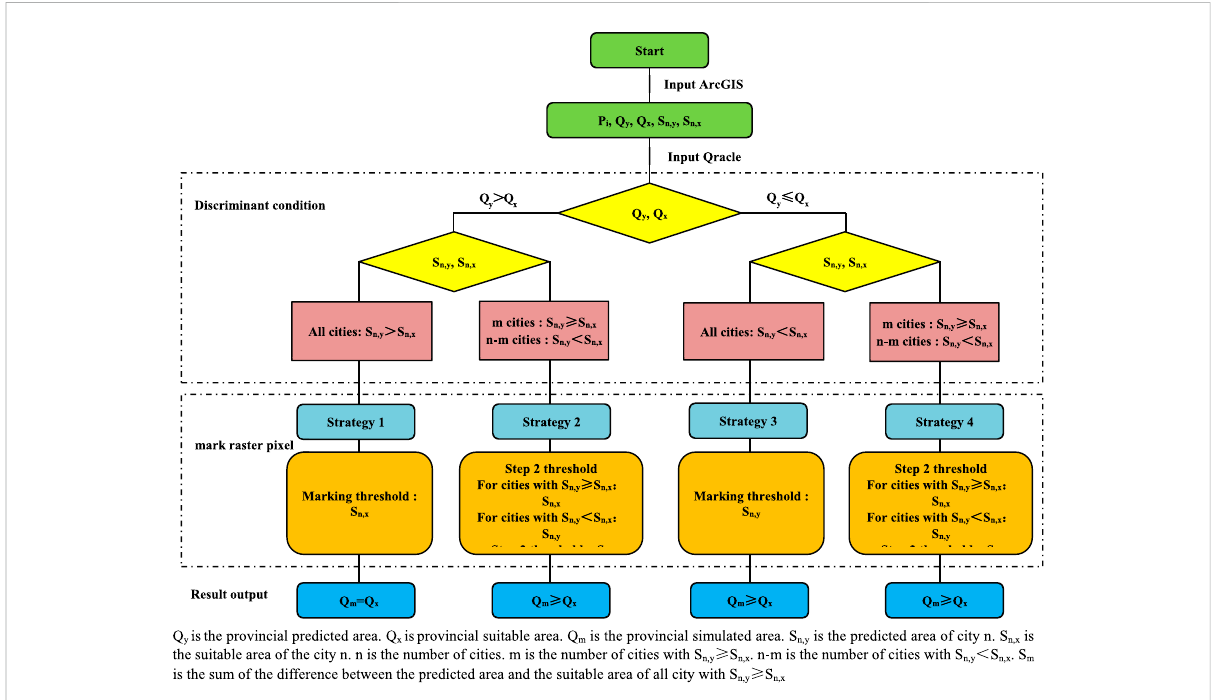
FIGURE 4 Discrimination conditions and thresholds of